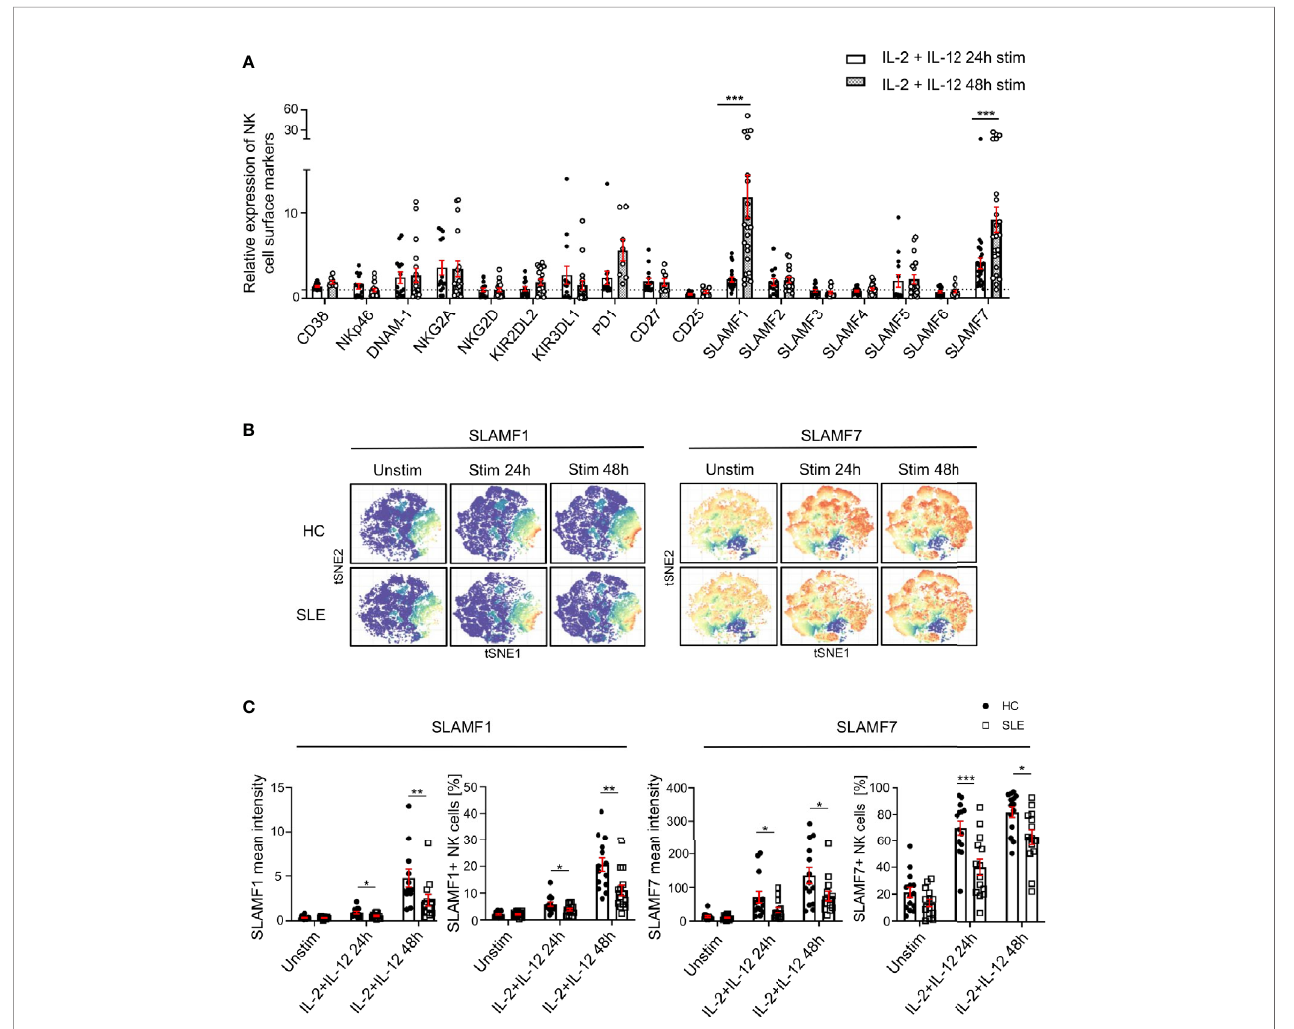
FIGURE 3 | SLAMF1 and SLAMF7 fail to be properly upregulated on the surface of SLE NK cells after activation with cytokines. (A) Expression of surface markers after 24h and 48h of stimulation with cytokines on healthy NK cells, standardized to their level of expression on unstimulated cells (HC=23, SLE=23; Mixed-effects analysis with Sidak ’ s multiple comparison test). (B) t-SNE presentation of the expression level of SLAMF1 and SLAMF7 in HC and SLE patients before and after stimulation with cytokines (down-sample HC=12 ’ 000 cells, SLE=12 ’ 000 cells). (C) Comparison of expression of NK cell surface markers after 24h and 48h of stimulation with cytokines between HC and SLE patients as mean intensity (above) and frequency (below) (HC=14, SLE=14; two-way ANOVA and Sidak ’ s multiple comparison). Data represent mean ± SEM (*P < 0.05, **P < 0.01, ***P < 0.001). HC, healthy